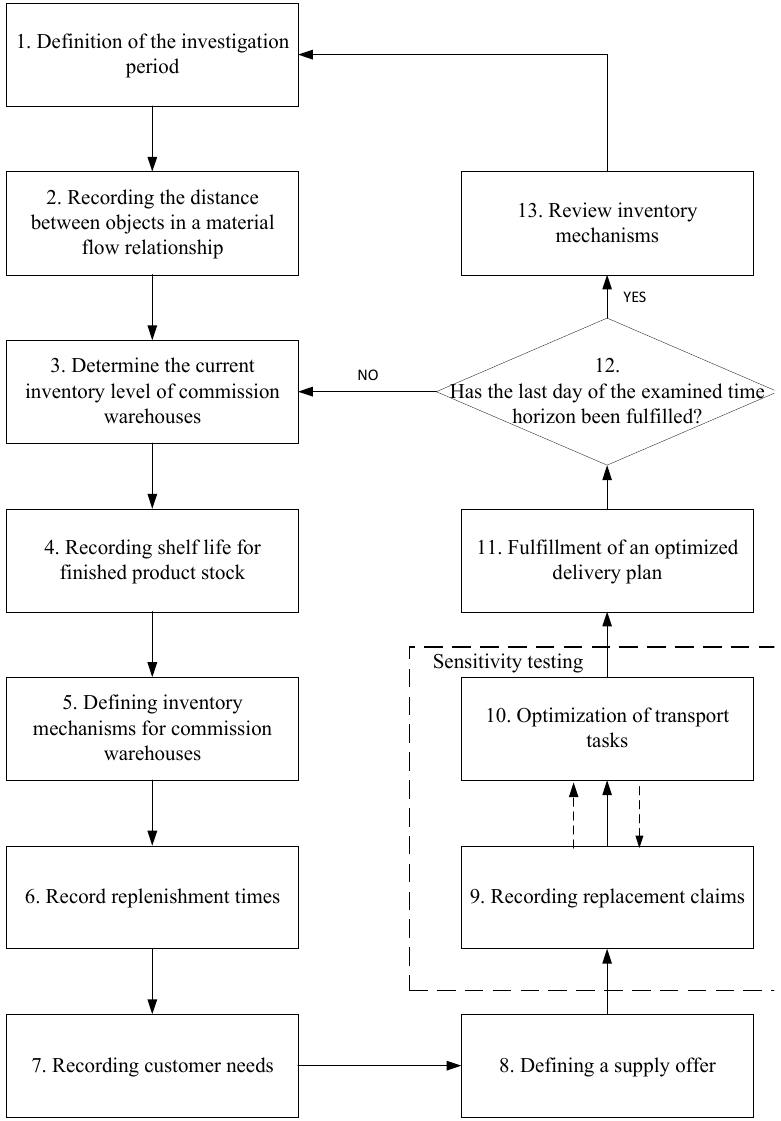
Figure 7. Commissioned supply chain distribution logistics optimization process (Source: Self-edit).